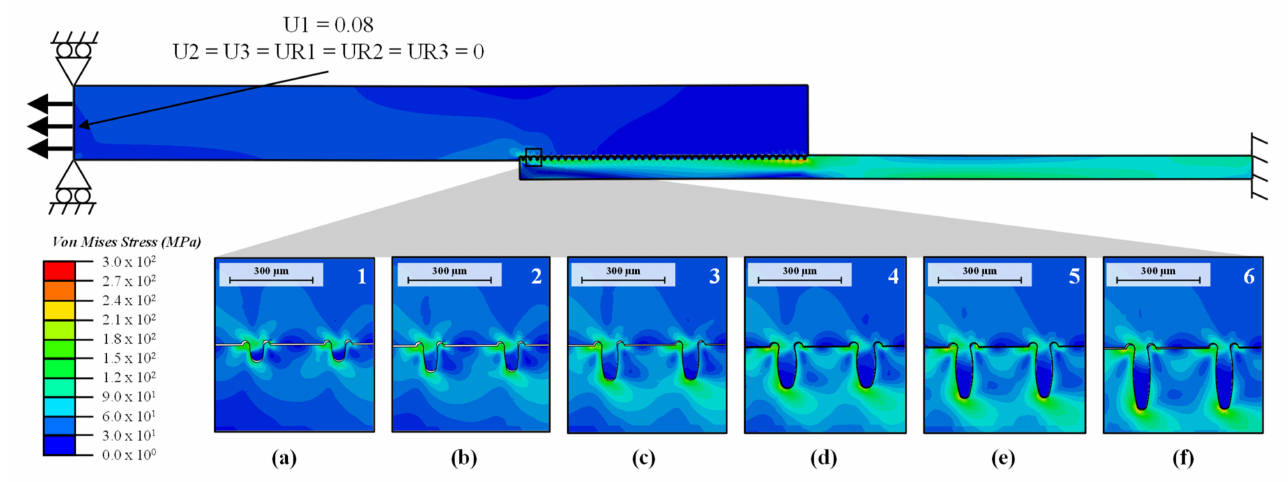
Figure 6. Illustration of the stress distribution (U1 = 0.08) of the single lap joint specimen of the finite element model. In ( a – f ) detailed sections for the different microstructures are shown.